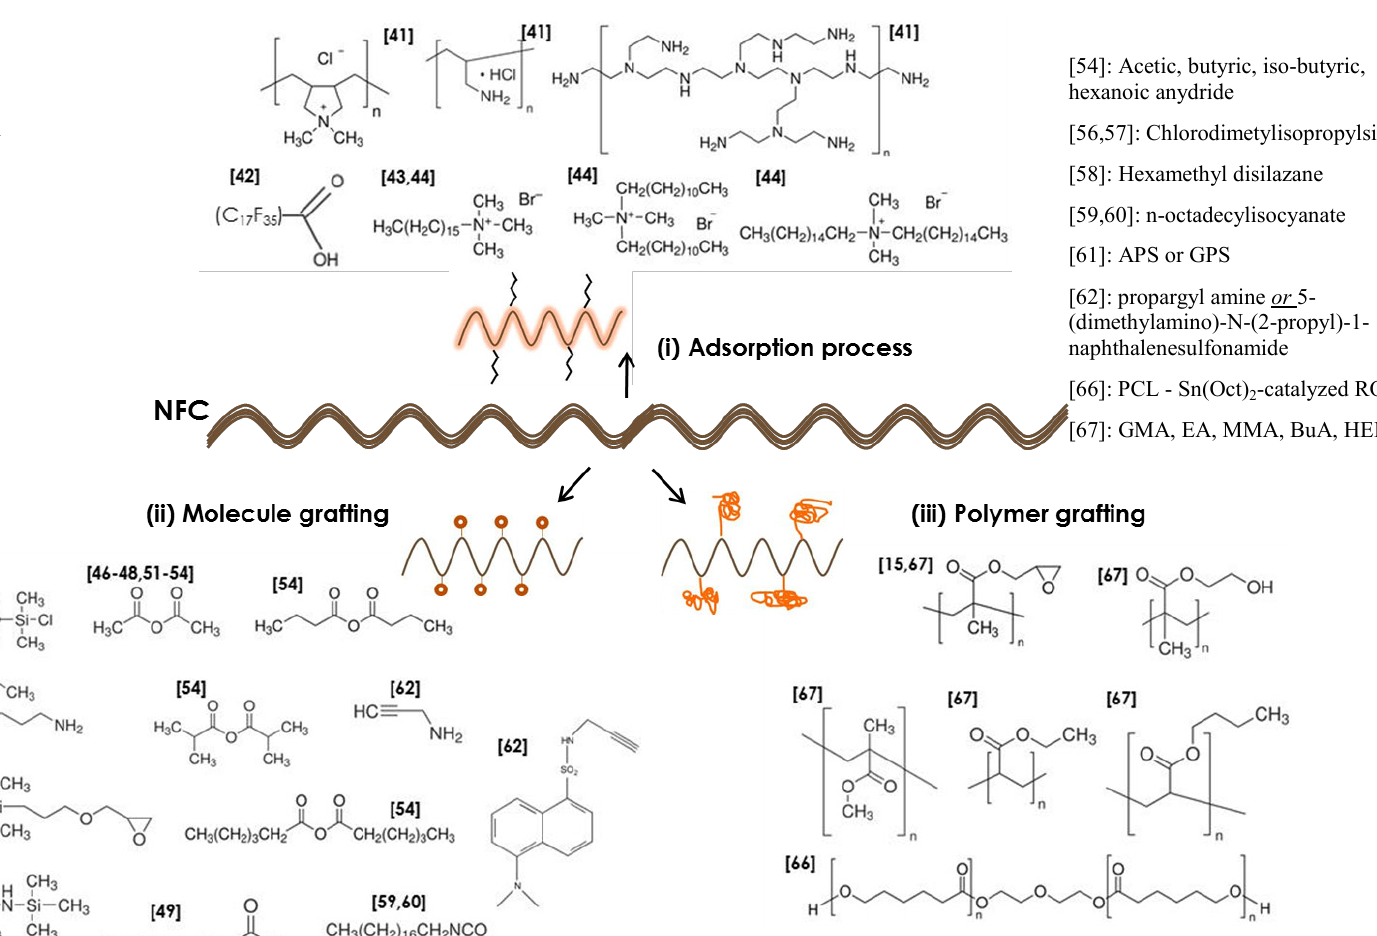
Figure 6. Exhaustive list of reagents used for modification of NFC. Three strategies adopted and described ( i ) physical adsorption, ( ii ) molecule surface modification and ( iii ) polymer grafting approaches reported in the literature (Sci Finder source updated in December 2012 — the number in brackets refers to the reference number from which the information was taken. All reagents are identified by their IUPAC name)